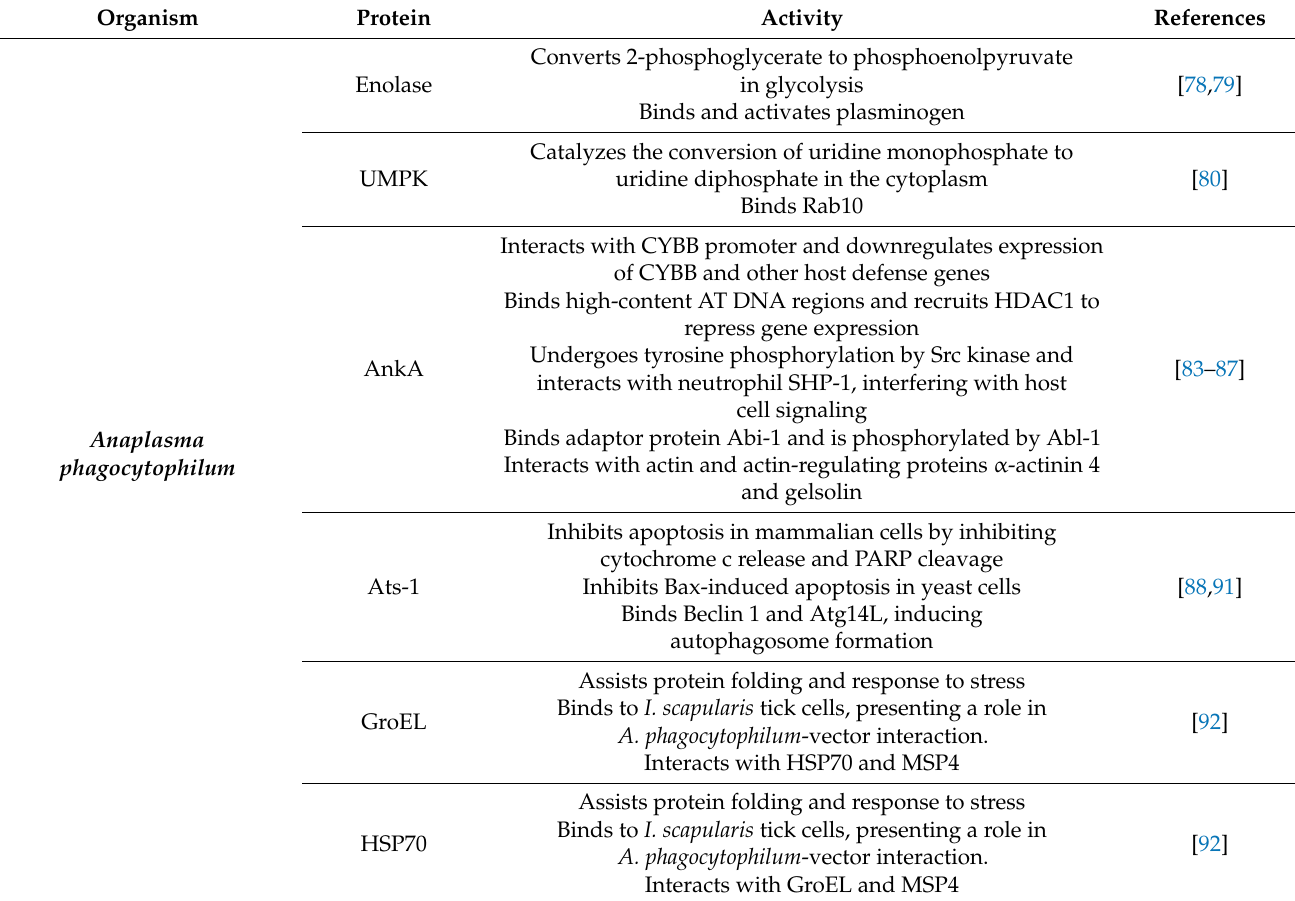
Figure 2. Examples of the multitasking proteins and their roles among the different members of the Rickettsiales: Anaplasma (A.), Ehrlichia (E.), Orientia (O.), Rickettsia (R.), and Wolbachia (W.). Details on each protein are provided in the text. Created with BioRender.com. Table 1. Moonlighting proteins reported in